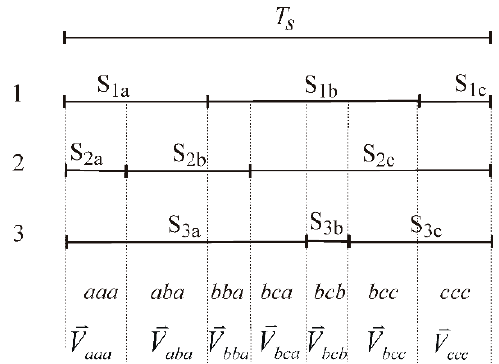
Figure 4. Synthesis of output voltages during T s switching period in classic Venturini modulation.